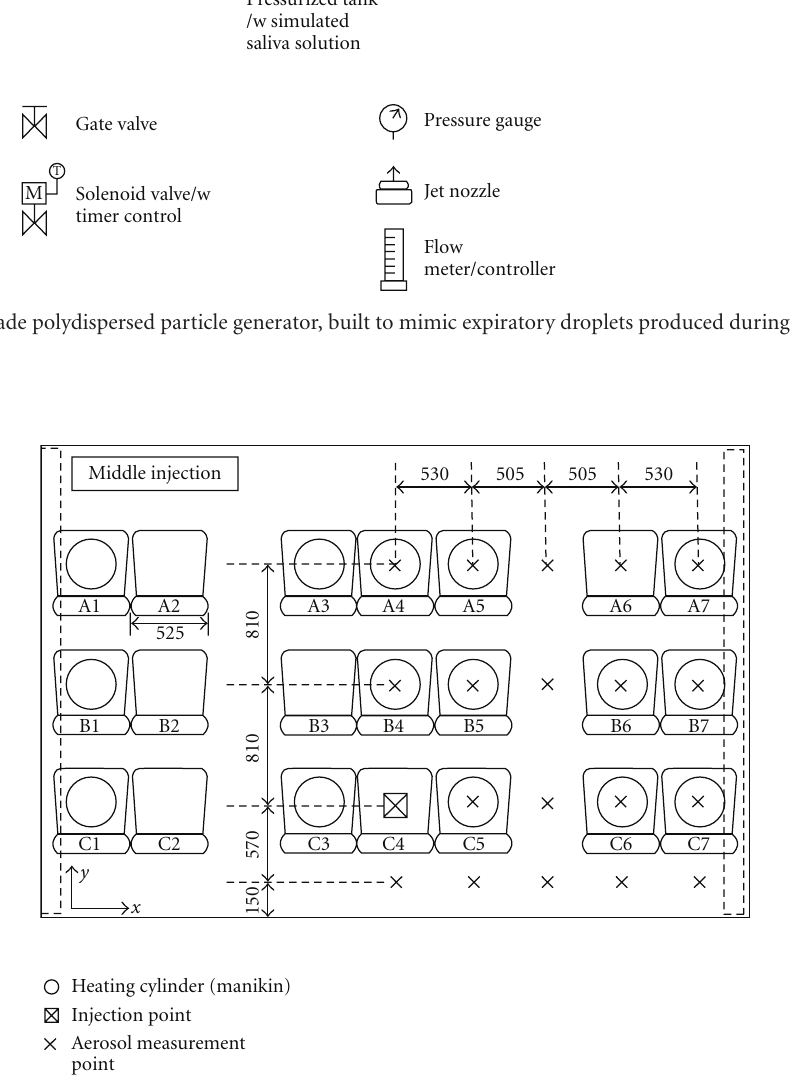
Figure 12: ICIEE cabin mockup with 21 seats